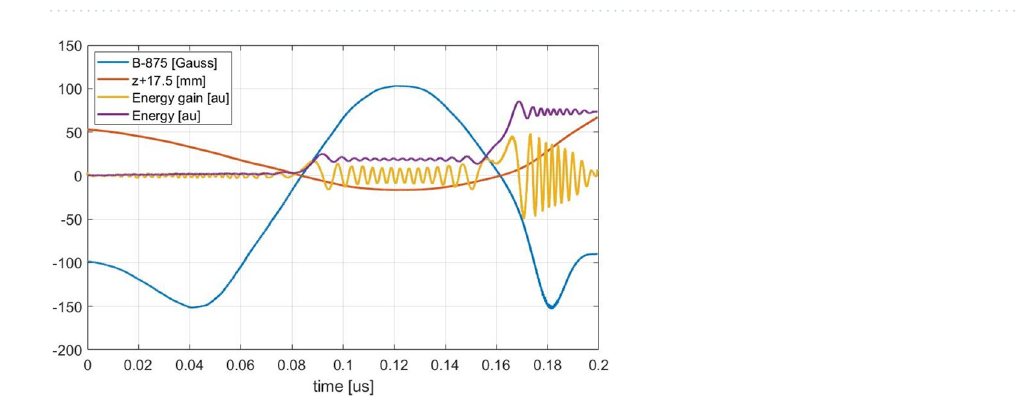
Figure 13. Longitudinal sections ( A , B ) and transversal sections ( C , D ) of the energy gain distribution, black lines mark the ECR regions.